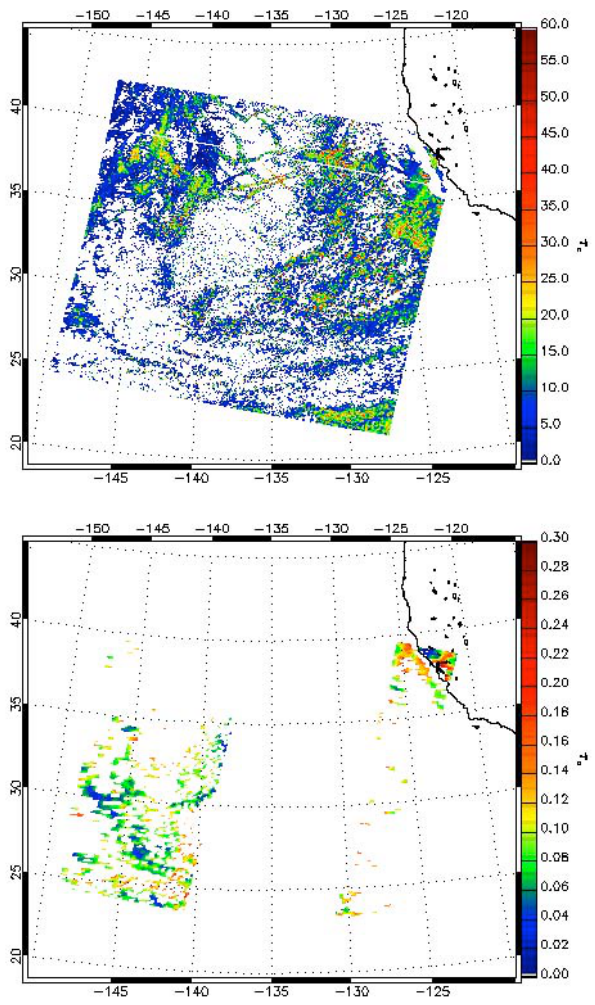
Fig. 9. MODIS Level 2 data over the northeast Pacific Ocean on 20 July 2001: cloud optical depth (top) at 1km resolution and aerosol optical depth (bottom) at 10km resolution.